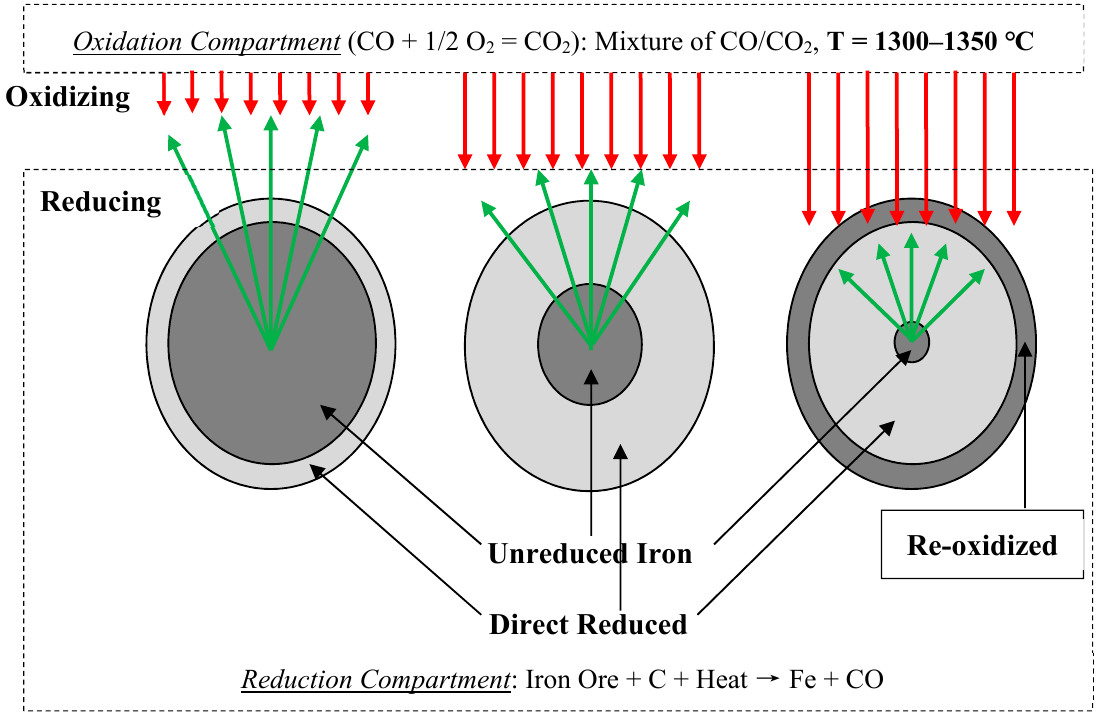
Figure 1. Schematic diagram of the carbothermic reduction in a shallow pellets bed.